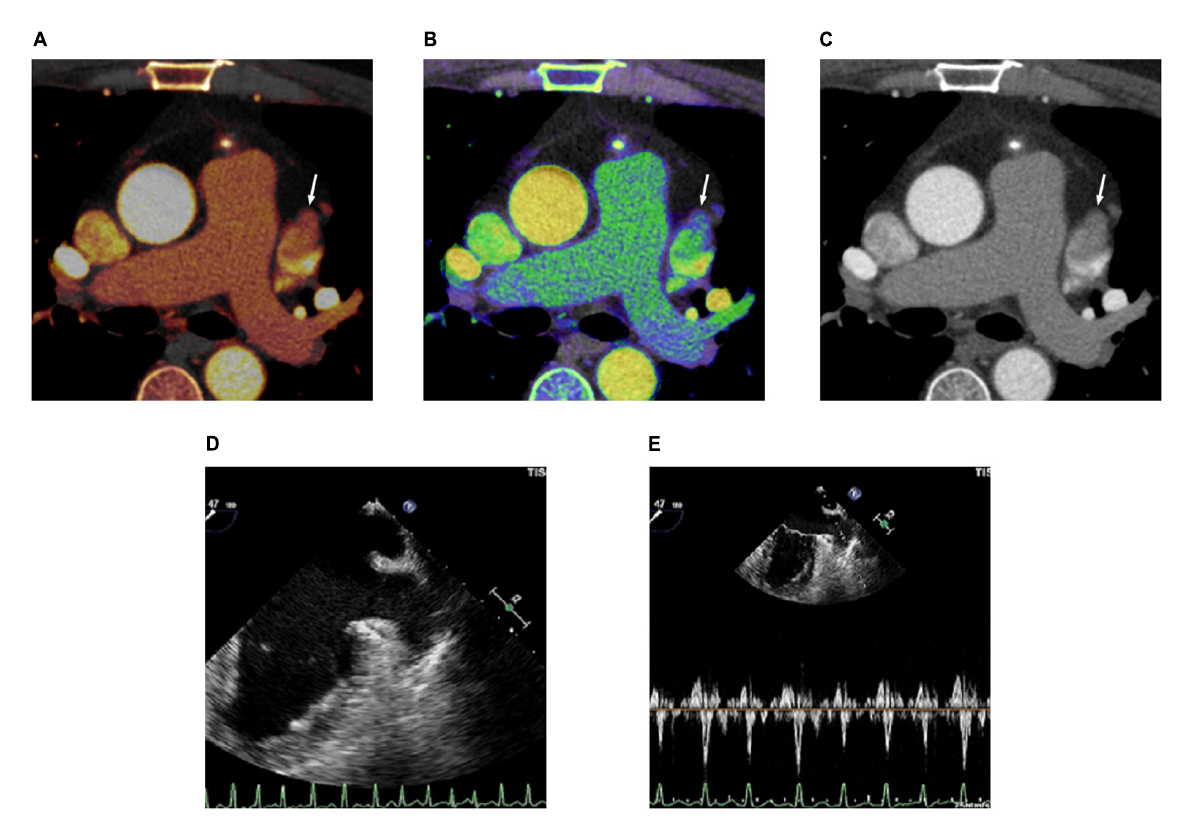
FIGURE4 Cardiac computed tomography (CT) and transesophageal echocardiography (TEE) images in 48-year-old man with spontaneous echo contrast (SEC). (A) Dual-energy CT-derived iodine map shows filling defect in the left atrial appendage (LAA) (arrow) with LAA/AA iodine concentration ratio of 0.13 (true negative finding). (B) Dual-energy CT-derived Z eff image shows filling defect in the LAA (arrow) with LAA/AA Z eff ratio of 0.68 (true negative finding). (C) Conventional CT image shows filling defect (arrow) in the LAA with LAA/AA HU ratio of 0.24 (false positive finding). (D) TEE image demonstrates SEC in LAA. (E) Doppler flow measurement of TEE shows reduced emptying velocity of 37 cm/s but measurable flow throughout the